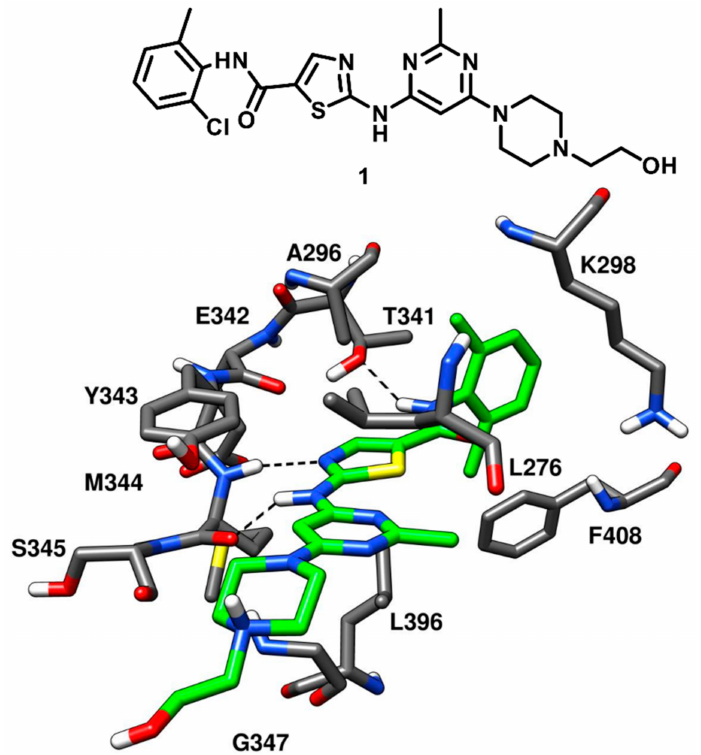
Figure 3. 2D structure of 1 and X-ray structure of c-Src kinase in complex with 1 (PDB ID: 3G5D). Active site residues of c-Src kinase and the enzyme–inhibitor H-bond interactions are